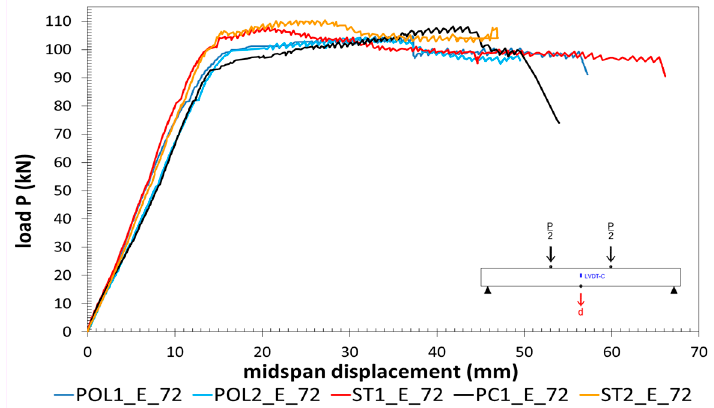
Figure 4. Load vs. mid-span deflection curves for beams aged for 72 months.